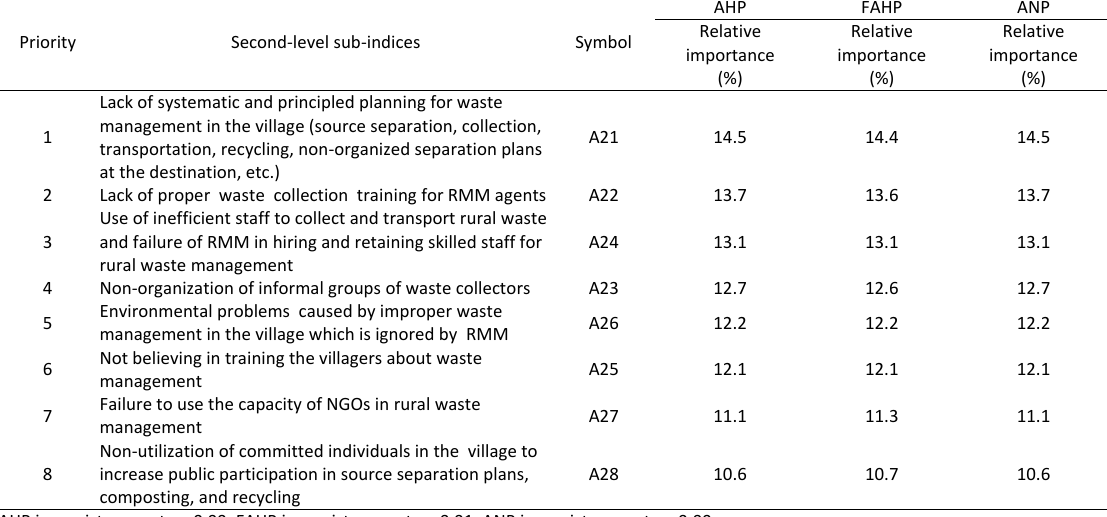
Table 2: Prioritization of weaknesses and relative importance values of the sub-indices of the A2 index based on AHP, FAHP, and ANP